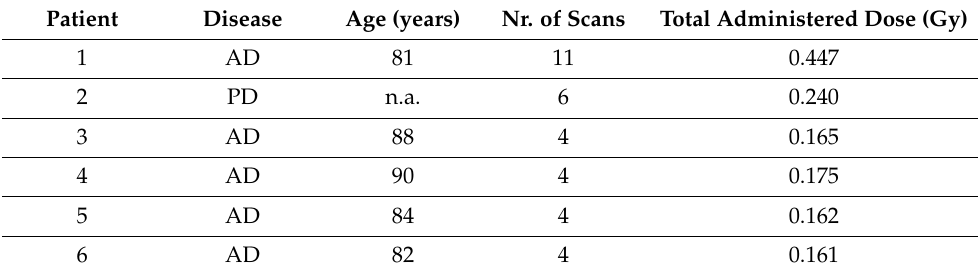
Table 2. Summary of the treatment details for the patients that underwent CT scans.